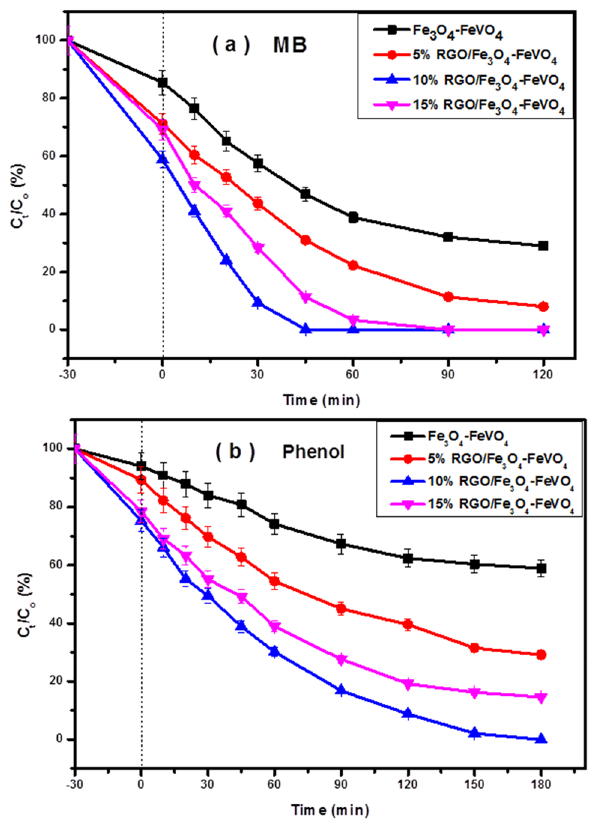
Figure 7. Photocatalytic degradation of ( a ) MB and ( b ) phenol over of Fe 3 O 4 –FeVO 4 and xRGO/Fe 3 O 4 –FeVO 4 nanocomposites versus irradiation time with error